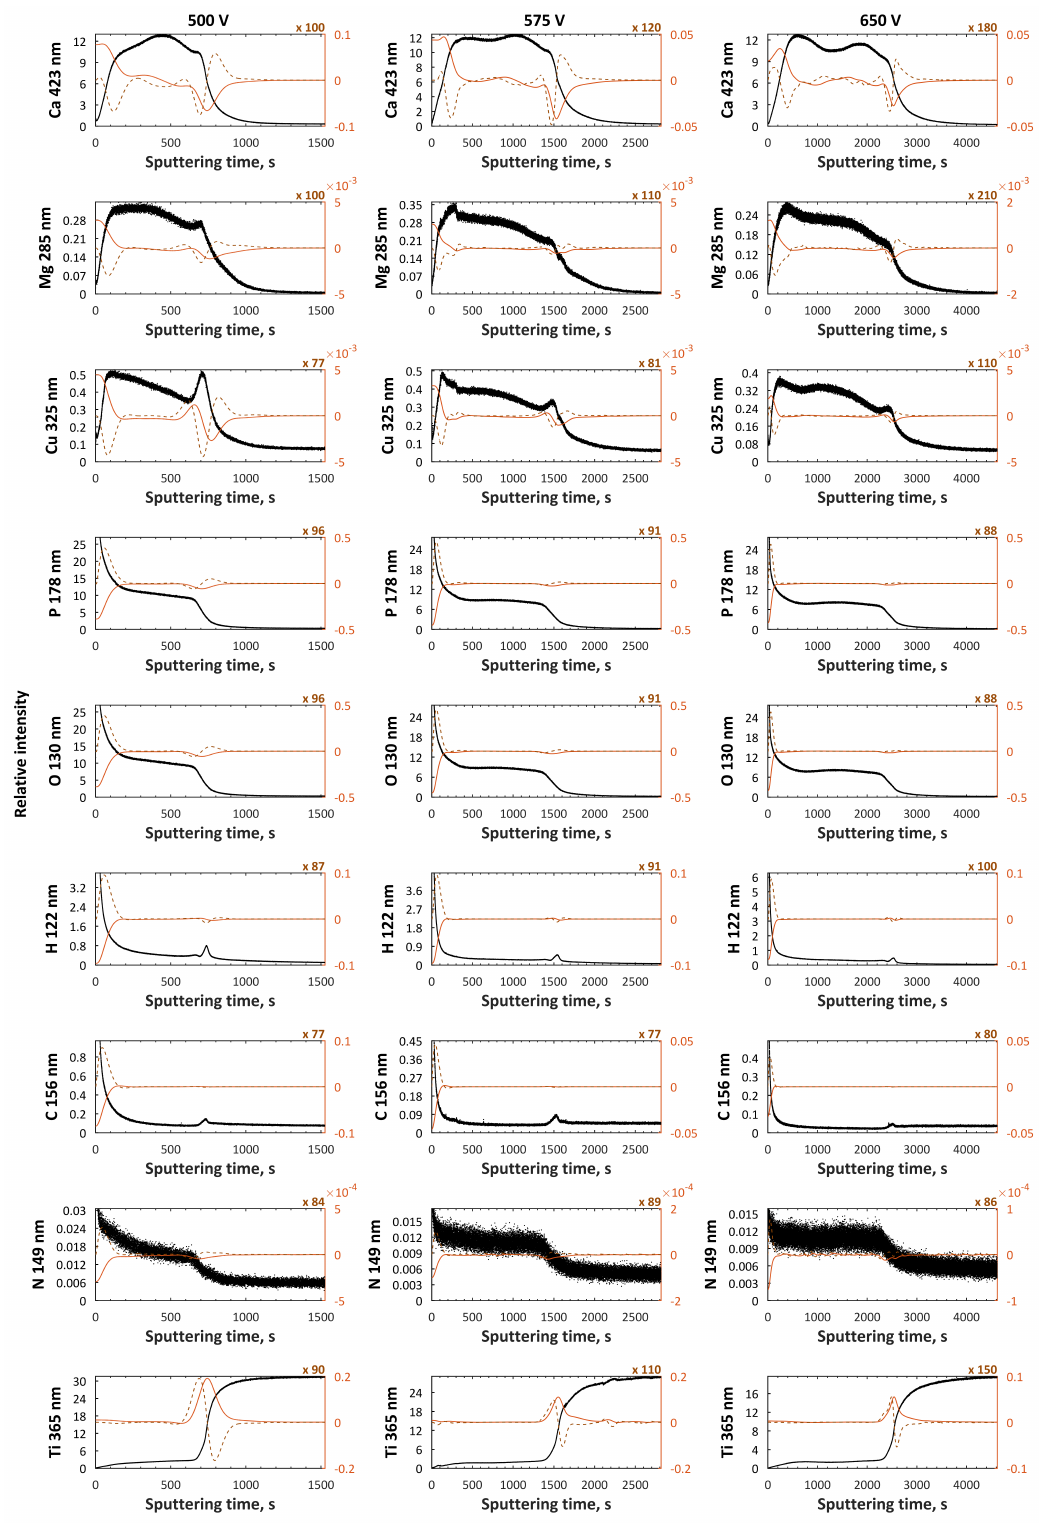
Figure 6. GDEOS signals (black), first derivatives (red continuous line), and second derivatives (brown dashed line) for samples formed in Electrolyte